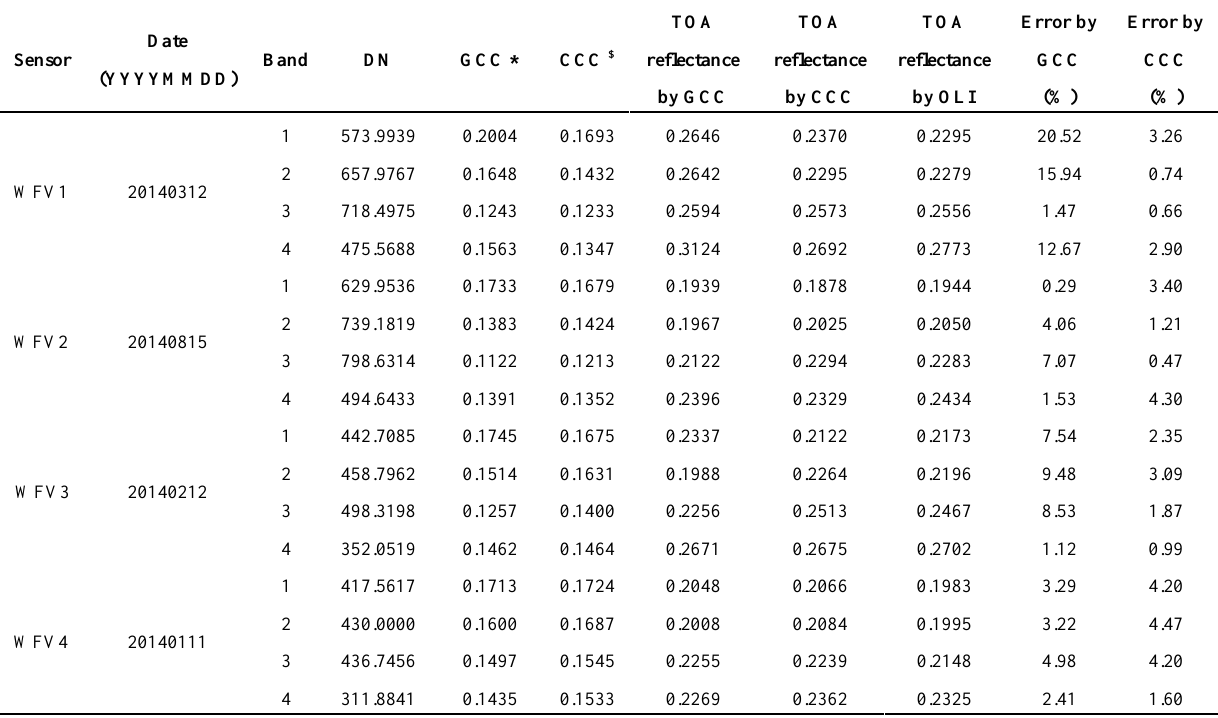
Table 14. GF-1/WFV cross-calibration validation